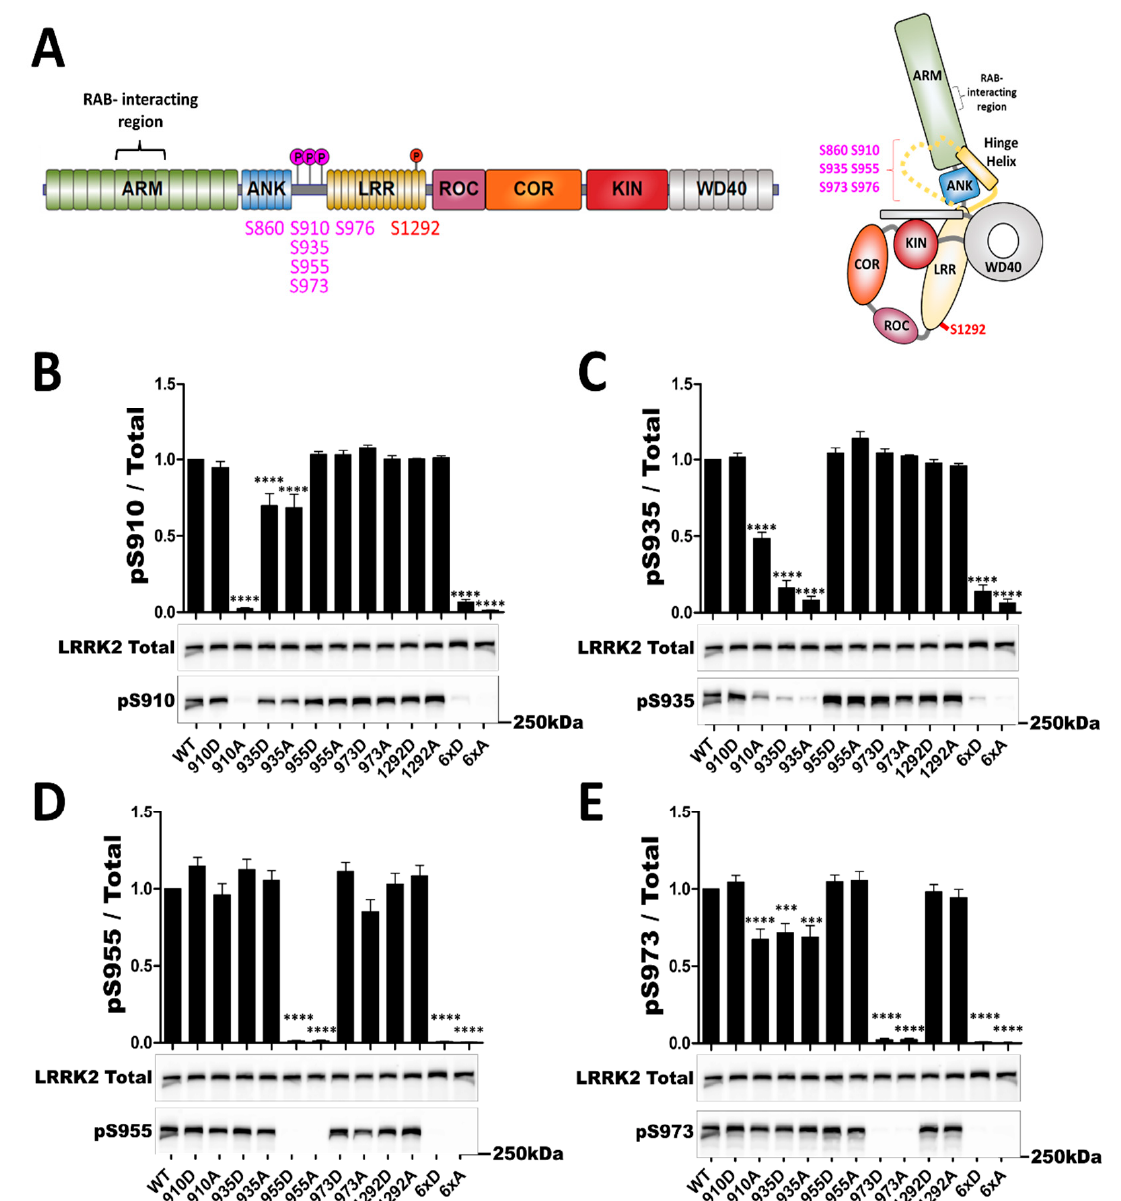
Figure 1. In cellulo phosphorylation profile of LRRK2 phosphosite mutants. Western blot analysis of HEK293T cell lysates after transfection of LRRK2 phosphomutants. LRRK2 protein domain representation with studied phosphorylated sites (heterologous sites are represented in purple and autophosphorylation site in red). ( A ) Schematic representation of LRRK2 domains, as well as the spatial arrangement of LRRK2 domains, indicating locations of phosphosites studied in the present work as well as the reported RABs interaction region. Unresolved portions of the structure are represented as dashes. Adapted from [46]. The ratio of phosphorylated site over total LRRK2 signal is shown in ( B ) for S910, ( C ) for S935, in ( D ) for S955 and in ( E ) for S973. The blot image for total LRRK2 is reused for illustration purposes in ( B – E ). The data represents the mean ± SEM from four independent experiments. The quantification of the signals was done by using Typhoon FLA 9500 and ImageQuant software (ImageQuant Tl (IQTL) 8.1, GE Healthcare, Chicago, IL, USA). The data were analyzed by One-way-ANOVA followed by a Dunnett’s test, using the WT condition as control. (*** p < 0.001), (**** p <